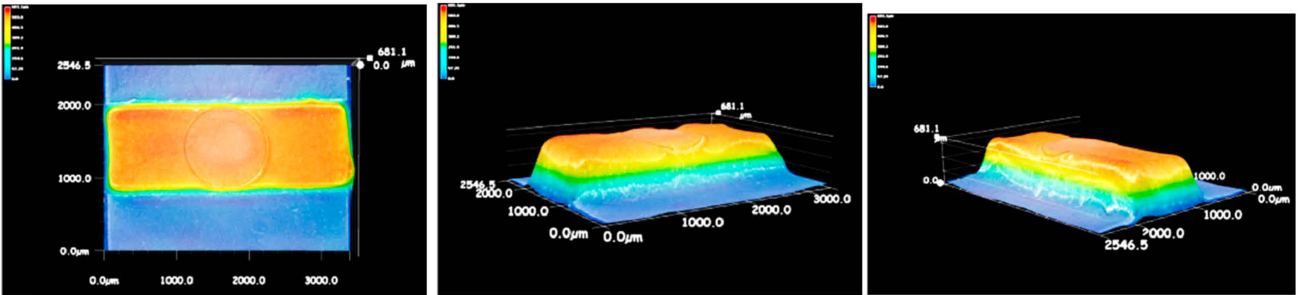
Figure 5. 3D images of the mold structure of PVDF/GP micro-part (GP content: 1 wt%).